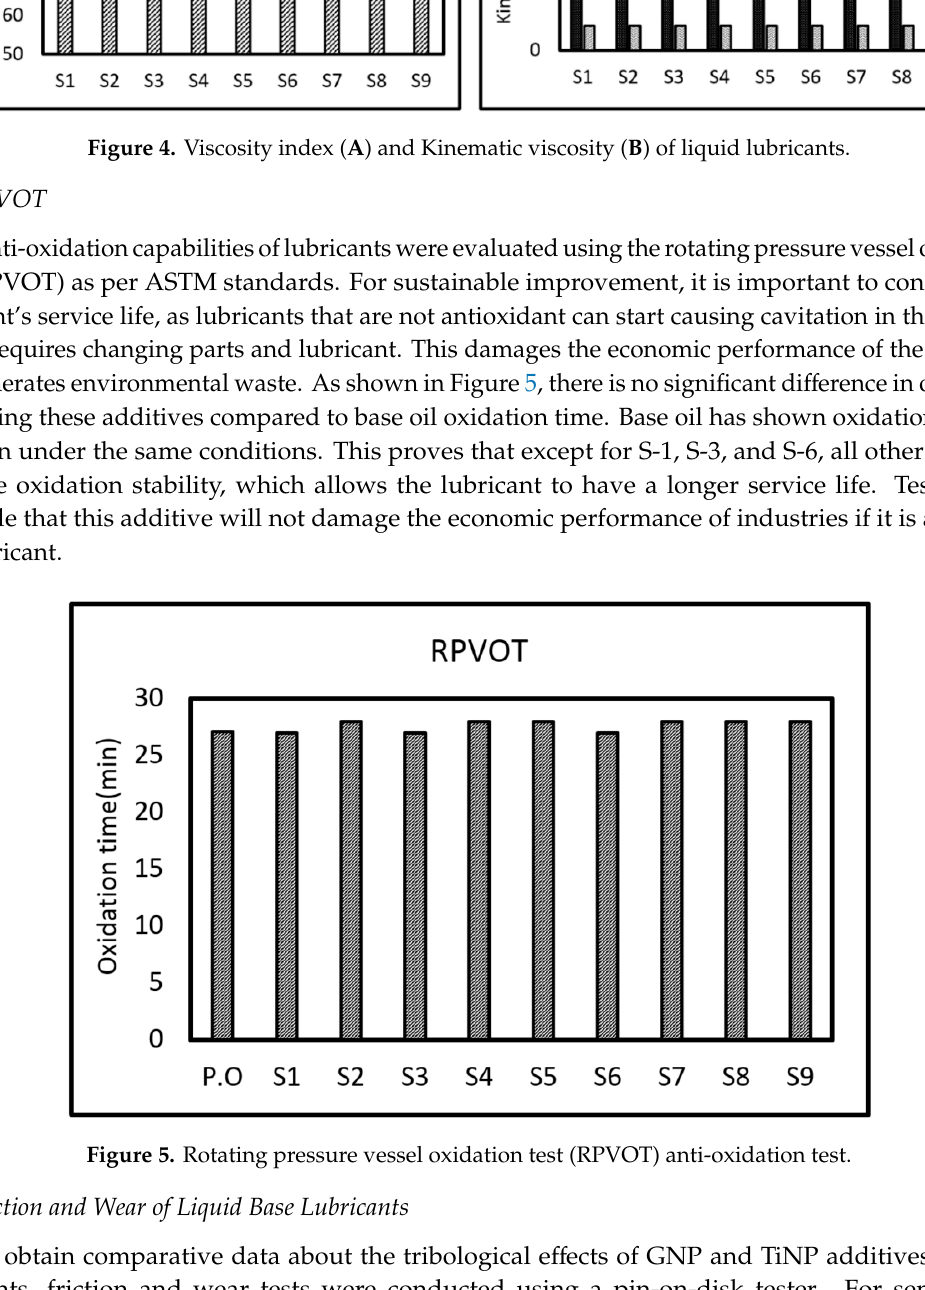
Figure 6. Friction coefficient and wear data (method for normalization: Z-score). The results of the liquid lubricant samples enhanced by GNP and TiNP were compared separately at different concentrations. In addition, the S-2 and S-4 nano additive concentrations were found comparatively effective for hybrid nano additives of GNP and TiNP; thus, three ratios and nano additives at this concentration (0.05%) were prepared and tested. The results displayed in Figure 6 manifest that GNP has a higher wear rate compared to the coefficient of friction. However, the TiNP samples reveal a lower wear rate and higher friction coefficient. This motivated our research